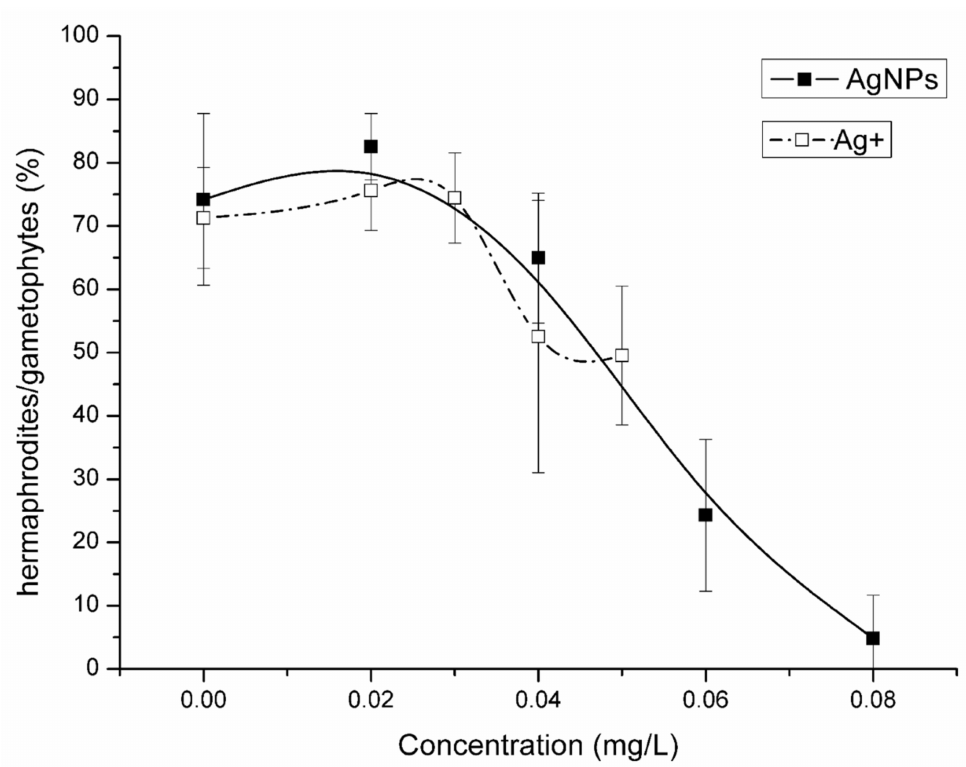
Figure 6. Effect of AgNPs and Ag + on the proportion of hermaphrodites after 19 d exposure. Data represent the mean ± SD ( n = 5).